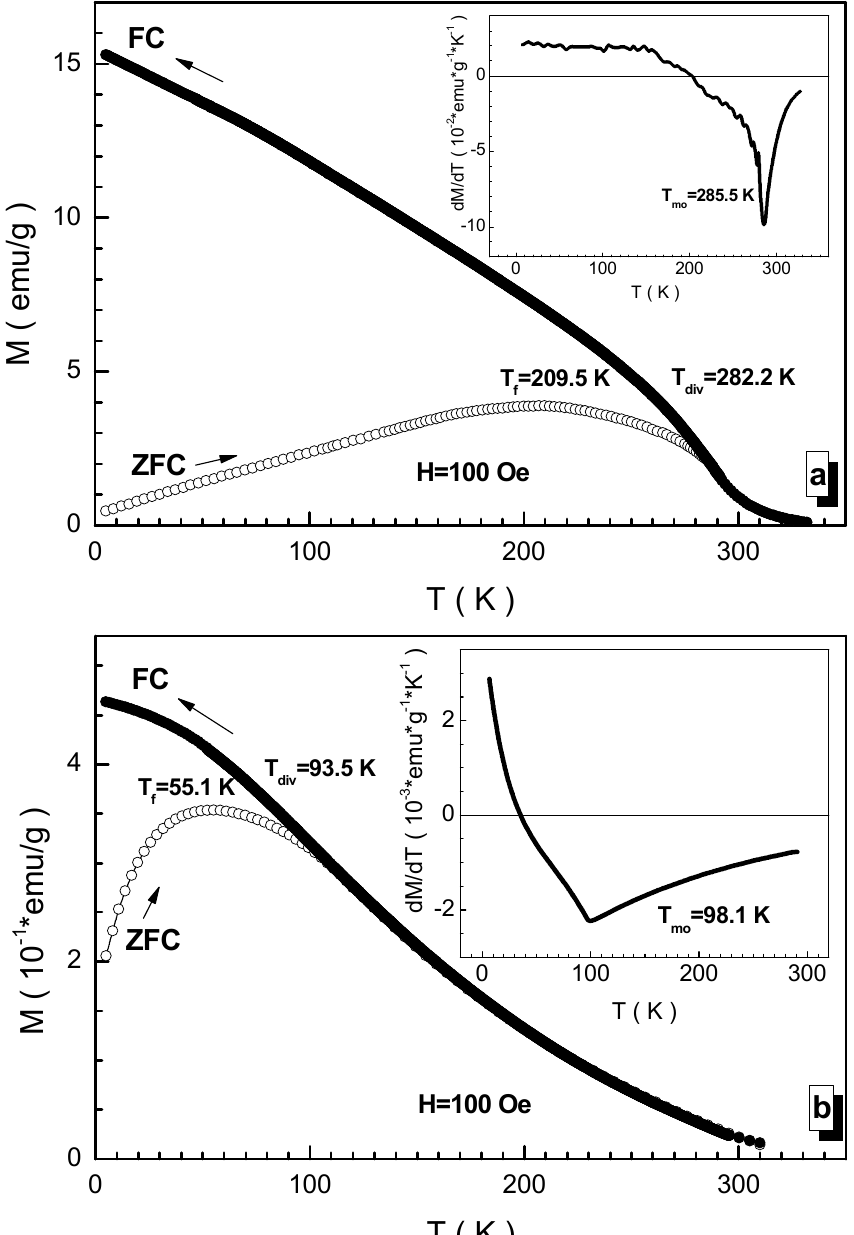
Figure 9. Temperature dependencies of magnetization in ZFC (open symbols) and FC (full symbols) regimes in field of 100 Oe for the compositions ( a ) BaFe 5.84 Ga 6.16 O 19 , ( b ) BaFe 6.26 Al 2.27 Cr 3.47 O 19 . Insets demonstrate the temperature derivatives of ZFC curves. The critical temperatures are defined.